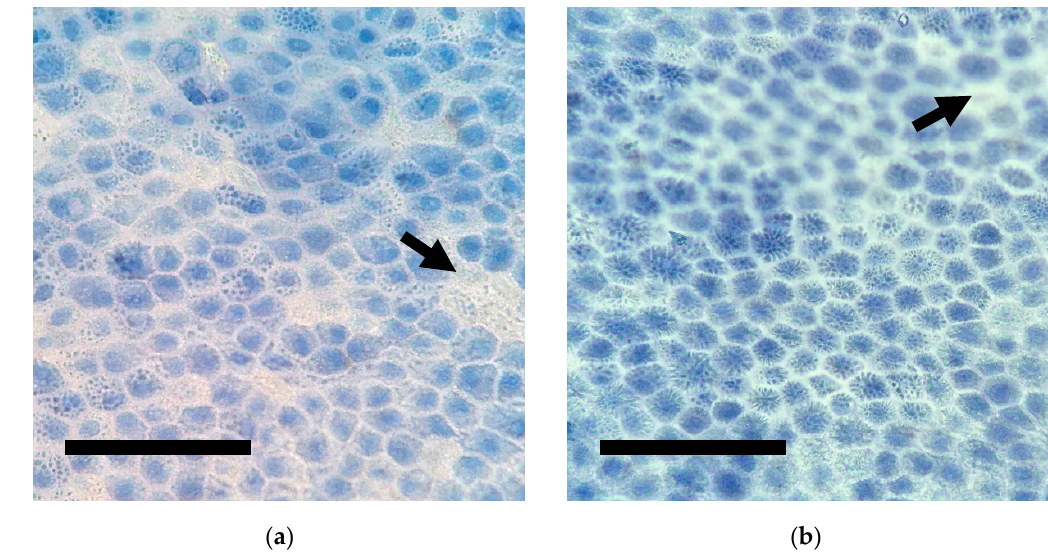
Figure 4. Representative microphotographs of trypan blue-stained single layer of epithelium of canine amniotic membranes after: ( a ) 7 days; ( b ) 30 days of cryopreservation. Note the unstained viable cells (black arrows). (Scale bar = 100 micron).